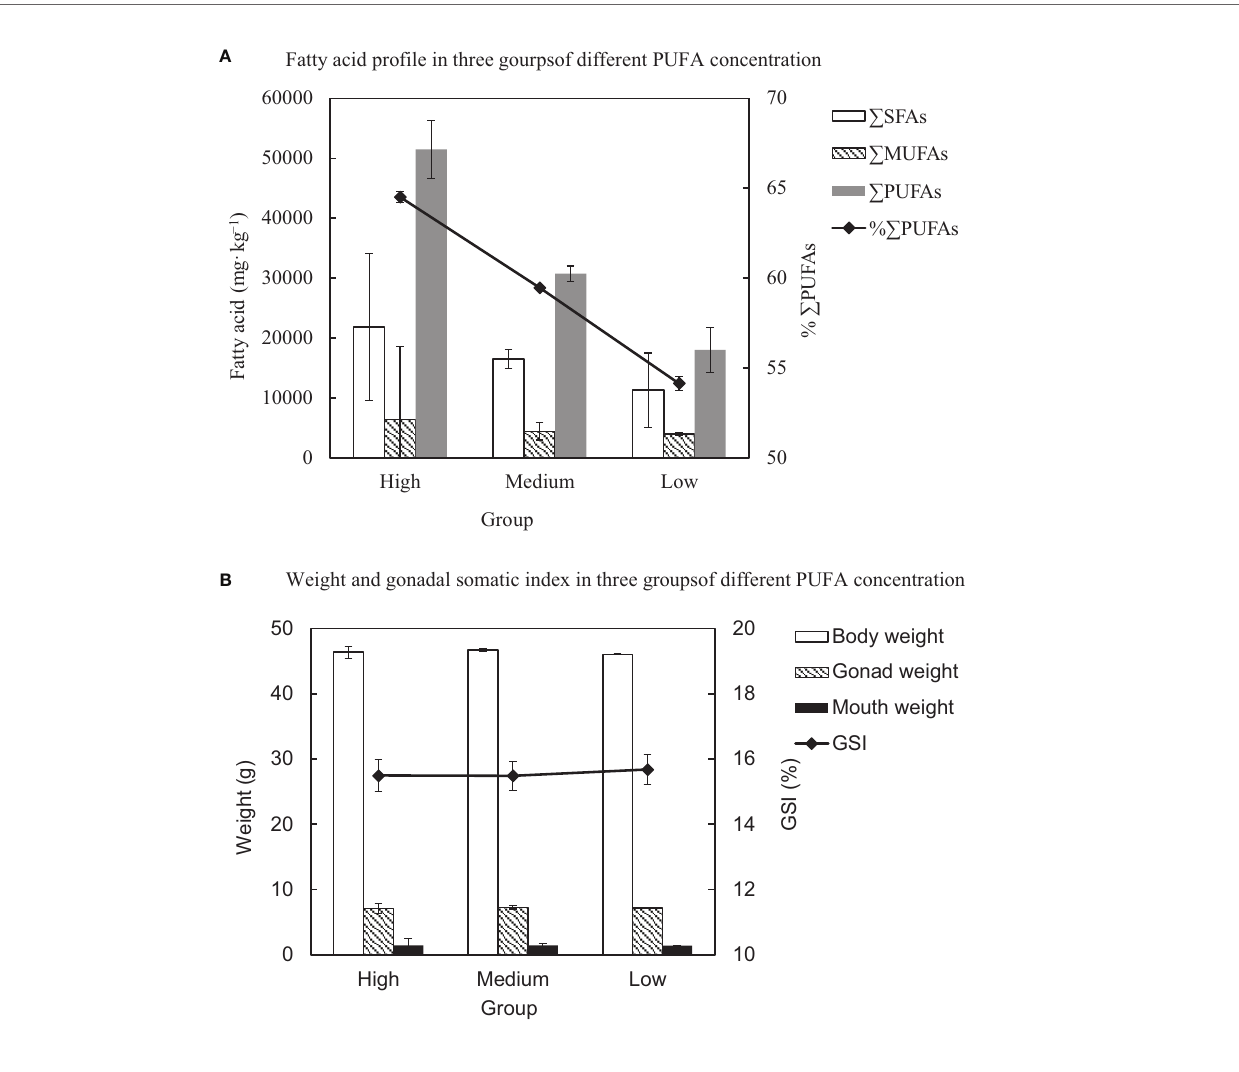
FIGURE 1 | Characteristics of sea urchin Strongylocentrotus intermedius in three groups of different PUFA concentration. (A) Fatty acid pro fi le; (B) weight and gonadal somatic index of sea urchin. The results are expressed as mean ± SEM (n= 3). SFAs, saturated fatty acids; MUFAs, monounsaturated fatty acids; PUFAs, polyunsaturated fatty